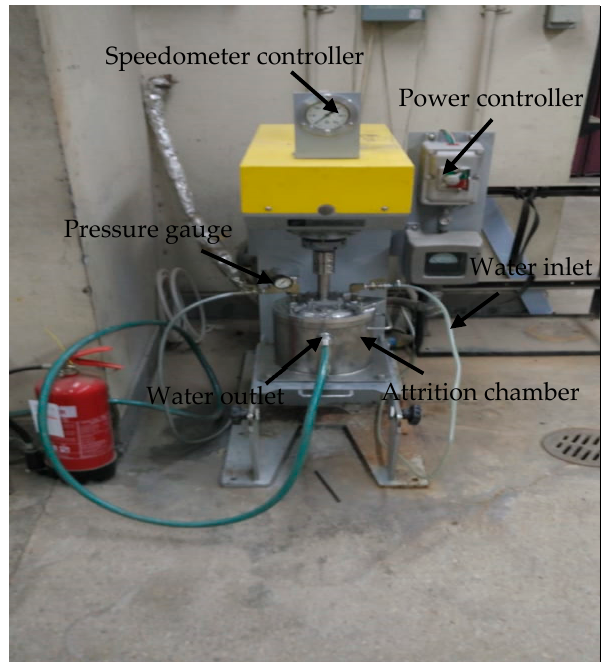
Figure 1. Attritor. Figure 1.